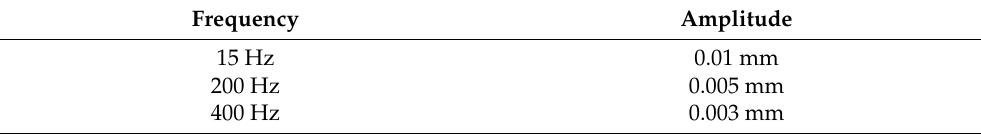
Table 1. The white noise of the position